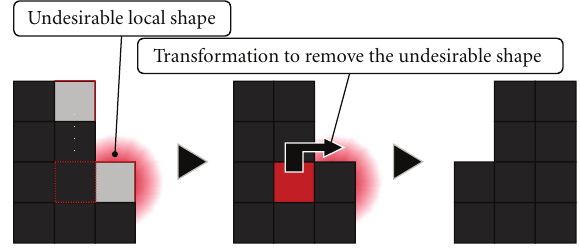
Figure 8: Methodology to generate transformations based on undesirability of local